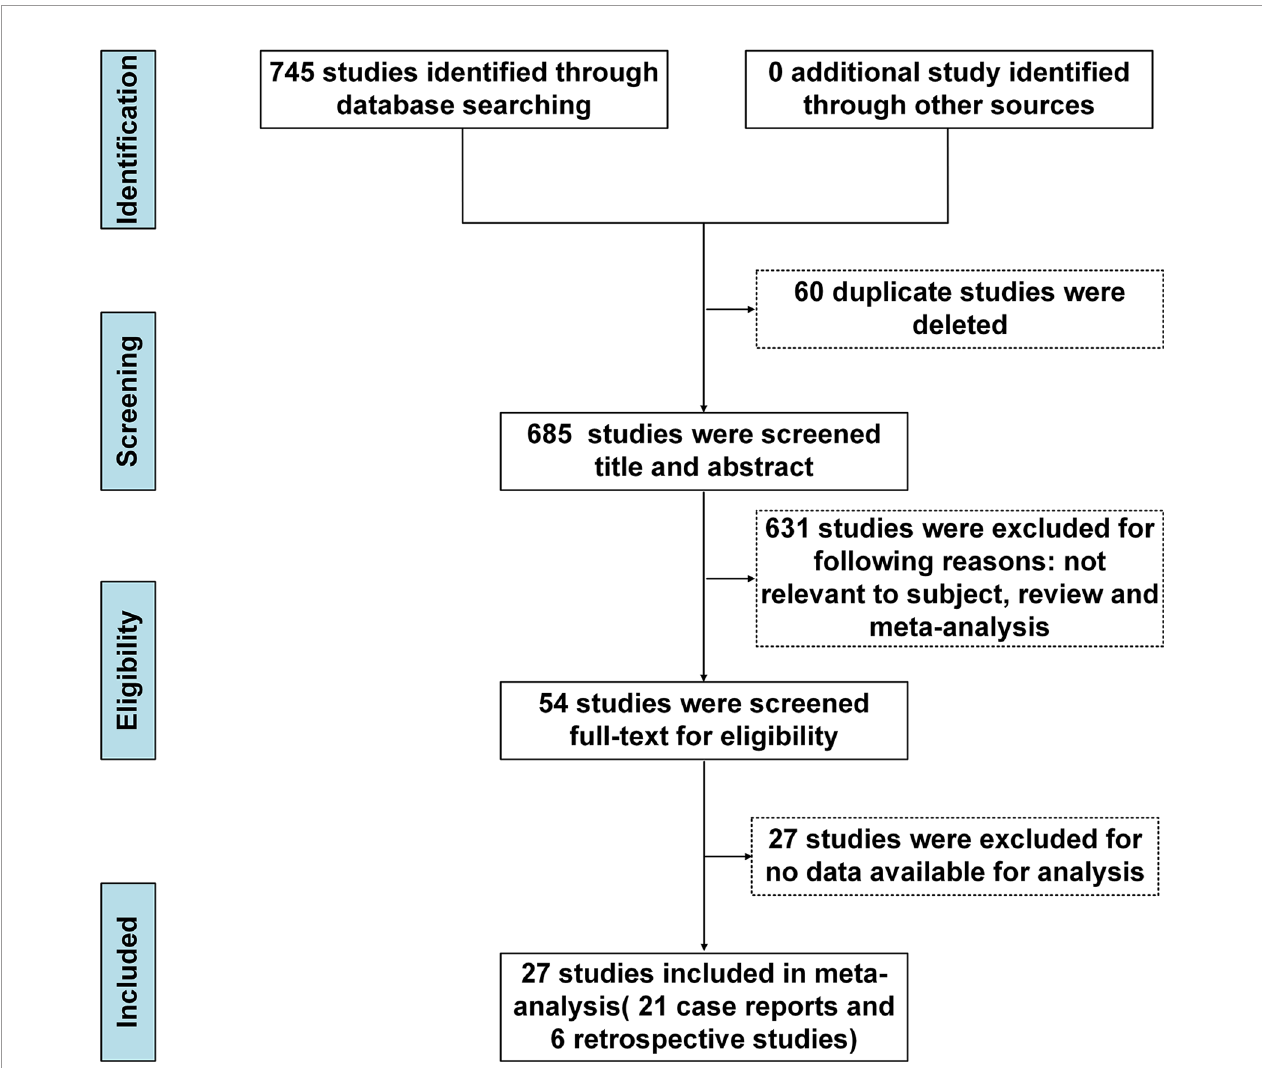
FIGURE 1 | PRISMA fl ow chart of inclusion process. PRISMA, Preferred Reporting Items for Systematic Reviews and